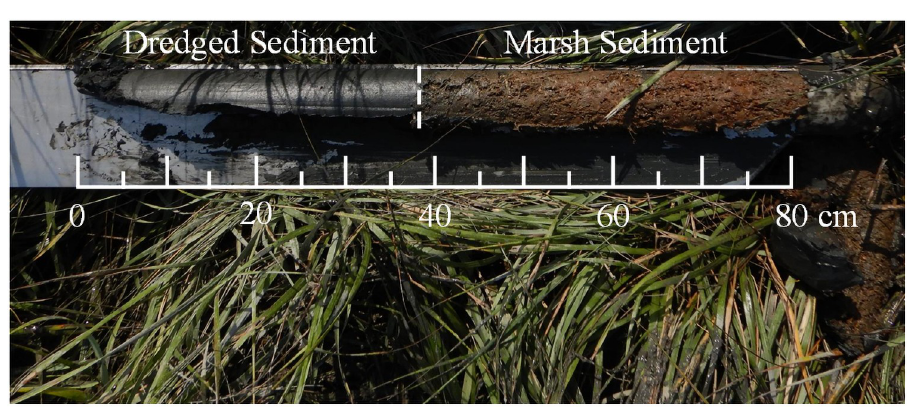
Fig 4. Example of Russian Peat Core sample from Transect A at 60 m. The shallower portion (left) showing the dredged sediment and the deeper (right) showing the vegetated marsh sediment.